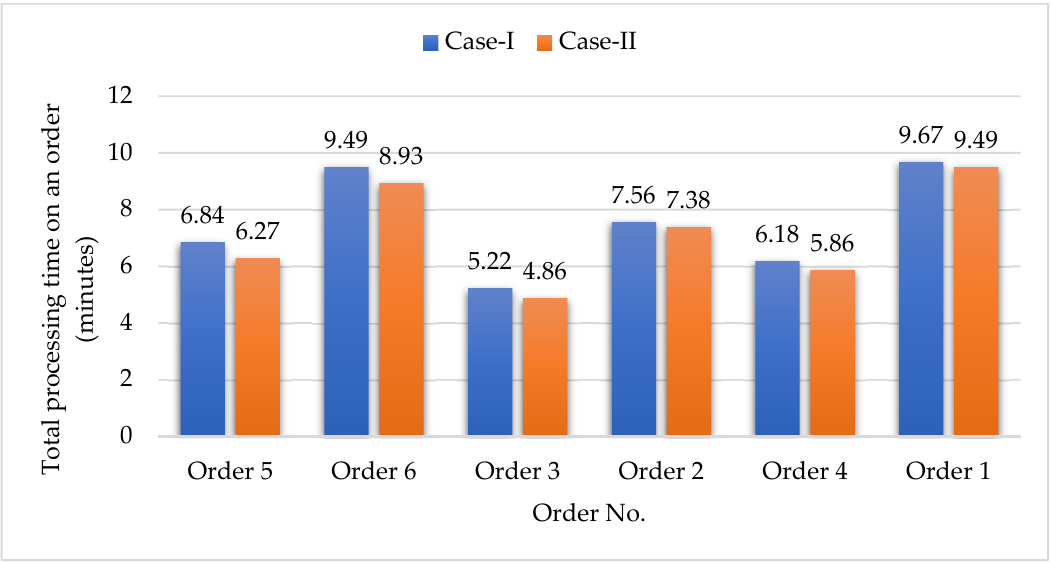
Figure 5. Comparison of the processing times for Case-I and Case-II using the SPT rule.